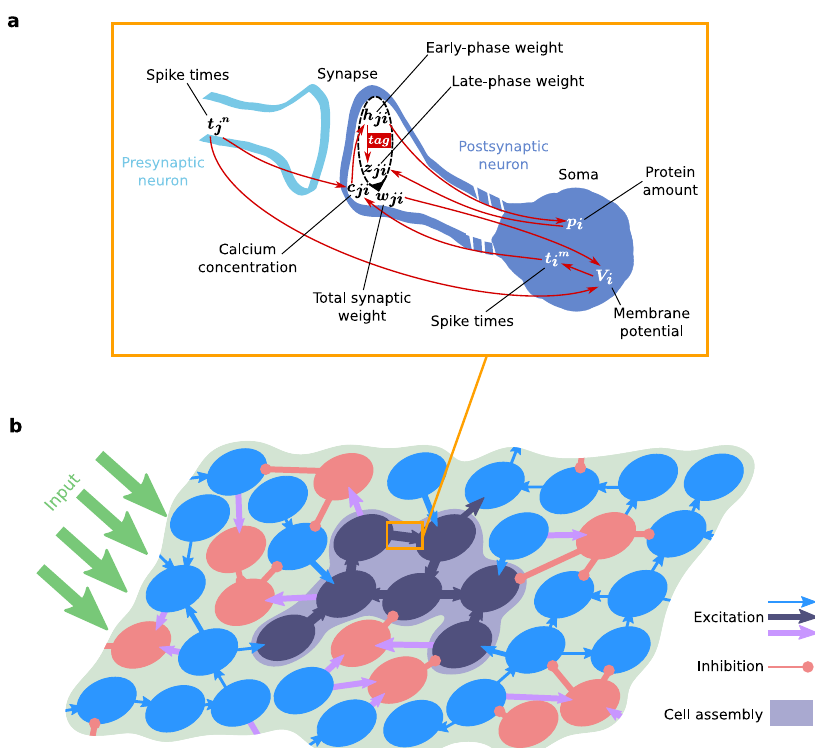
Fig. 1 Schematics of the synaptic model and the network model. a The synaptic model integrates the interplay between various mechanisms of calcium- dependent synaptic plasticity and the STC hypothesis. For more details see the main text. b Schematic of a part of the neural network that consists of excitatory (blue and dark blue circles) and inhibitory neurons (red circles), and receives external input from other brain areas (green arrows). Only synapses between excitatory neurons (blue and dark blue arrows) undergo plastic changes by the processes shown in a . A Hebbian cell assembly represents a memory and consists of a group of strongly interconnected neurons (dark